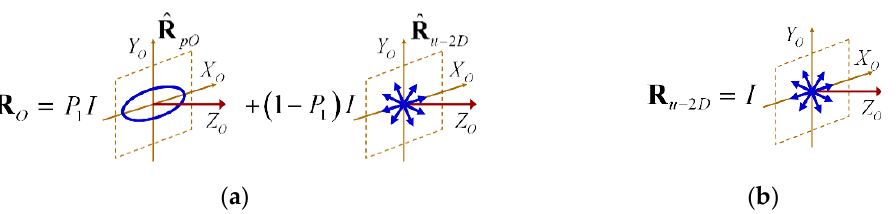
Figure 4. Intrinsic representation of the characteristic decomposition of a mixed 2D state